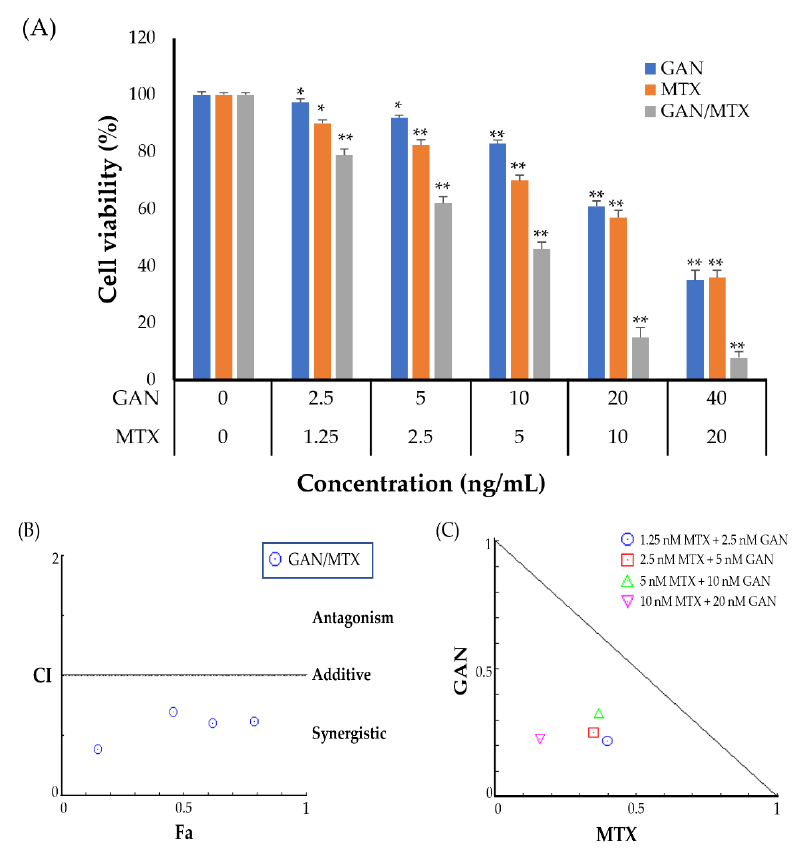
Figure 1. ( A ) Cell viability of A549 cells following treatment with either GAN or MTX alone or in combination. Data were expressed as mean ± SD. * p < 0.05 and ** p < 0.01 vs. untreated control. ( B ) Combination index plot (Fa-CI plot) of interaction between GAN and MTX against A549 cells. Fa: inhibitory effect, CI: combination index. An Fa of 0.5 represents 50% growth inhibition. ( C ) Isobologram generated with CompuSyn. Combination data points that fall below the line are synergistic; those above the line are antagonistic, and those on the line are additive.